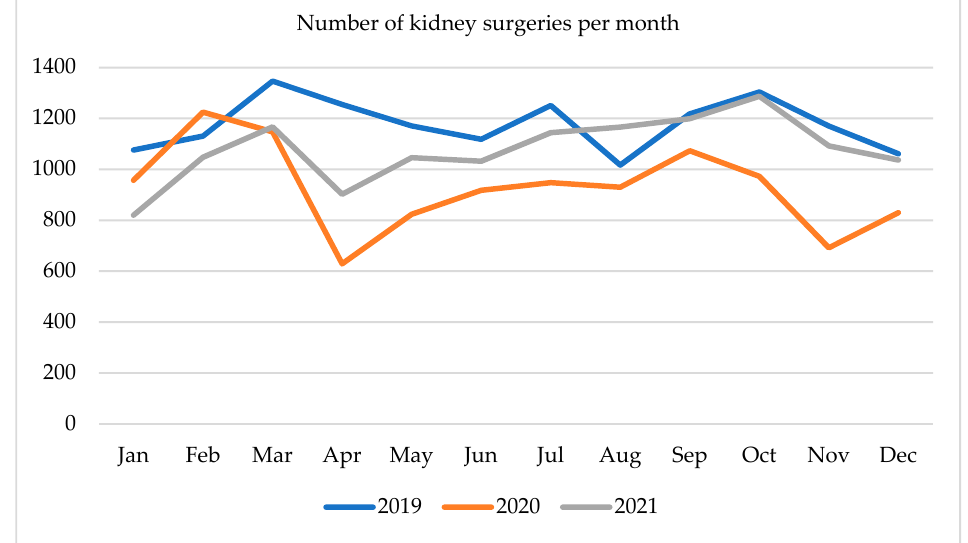
Figure 3 . Number of kidney surgeries per month in 2019–2021. Figure 3. Number of kidney surgeries per month in